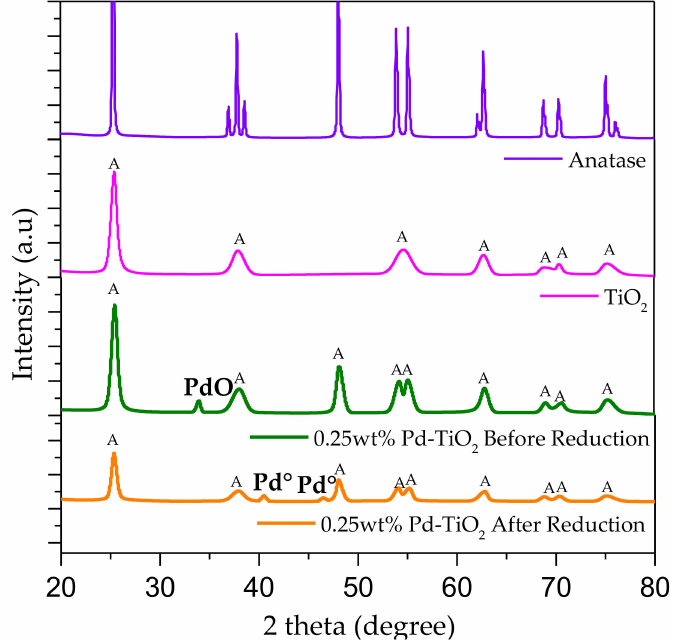
Figure 2. Comparative Analysis of 0.25 wt% Pd-TiO 2 Photocatalysts Before and After Reduction. A = anatase, PdO = palladium oxide and Pd ◦ = metallic palladium.